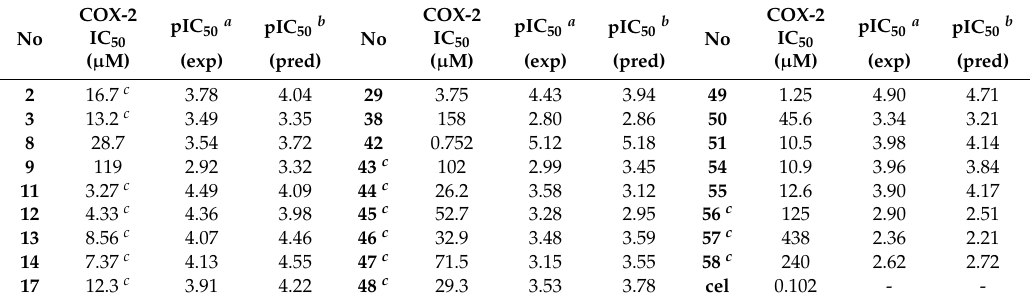
Table 5. In-vitro COX-2 inhibition of an in-house collection ( n = 26) of